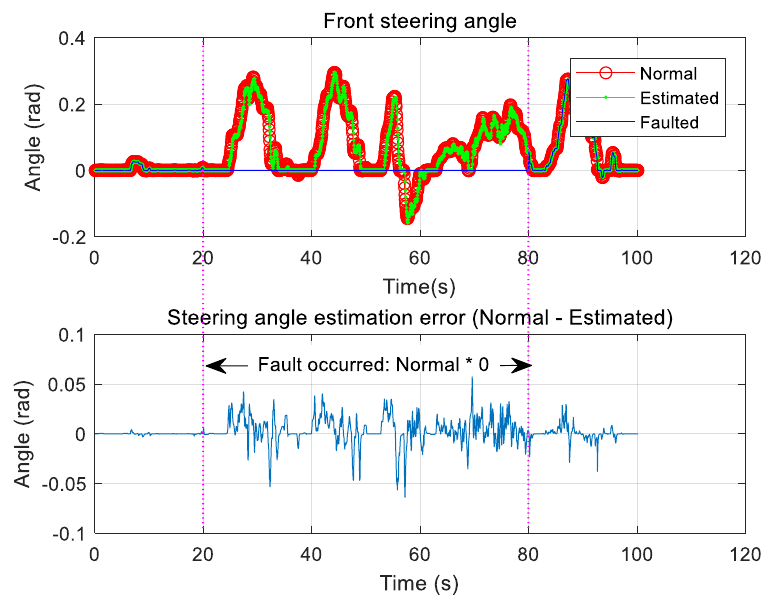
Figure 9. Type 1: Front steering angle sensor fault and estimation.